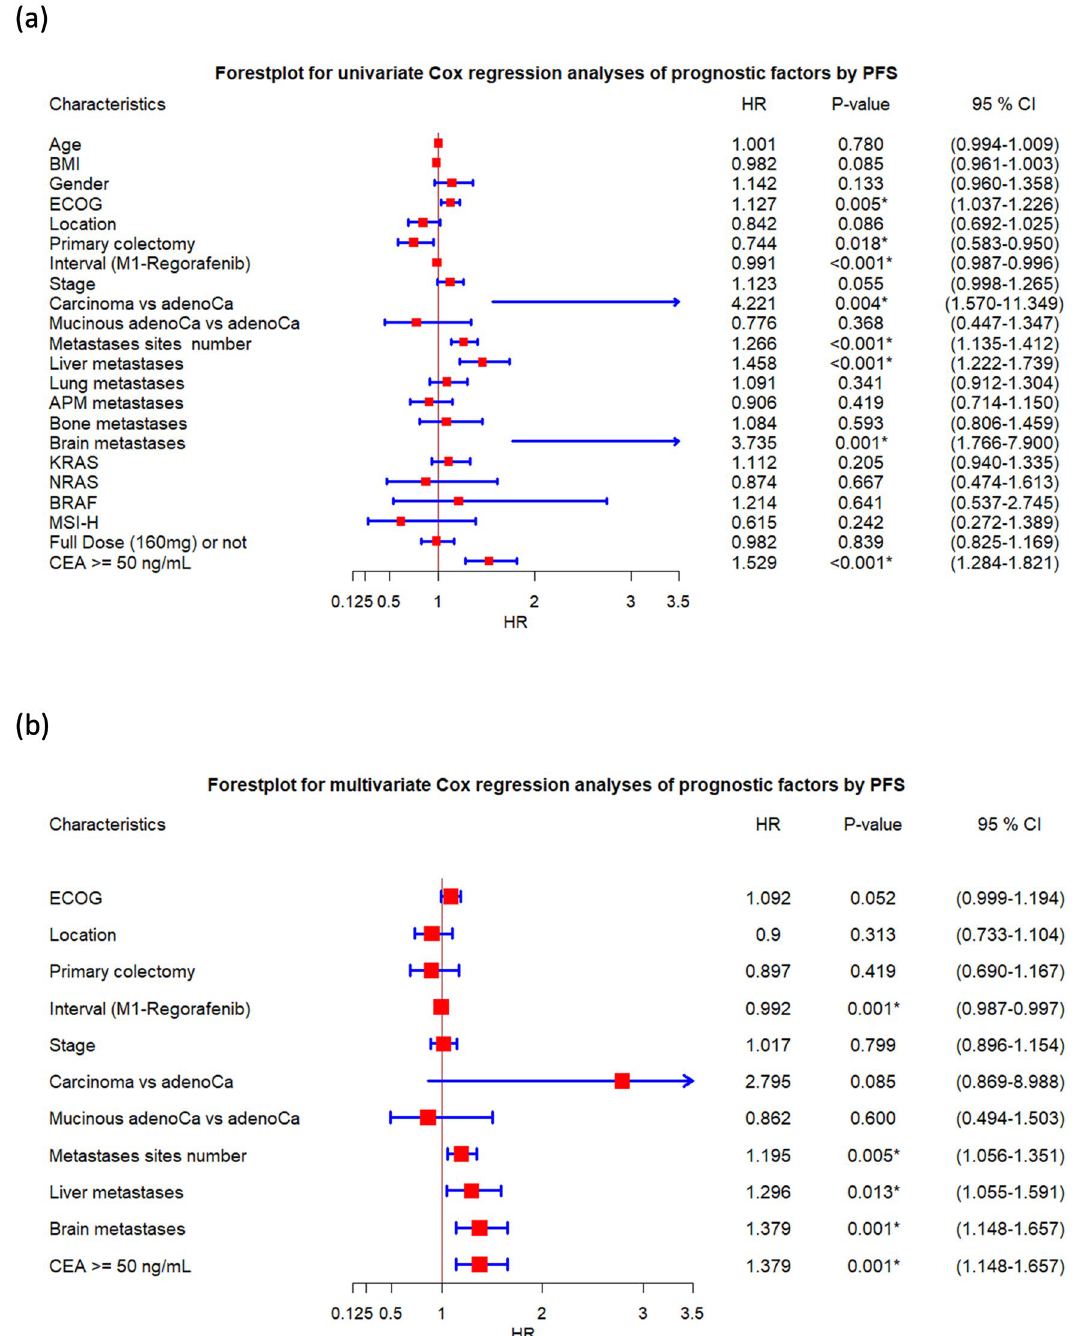
Figure 2. The forest plots summarize the ( a ) univariate and ( b ) multivariate analyses of prognostic factors in predicting progression-free survival (PFS). APM, abdominal/peritoneal